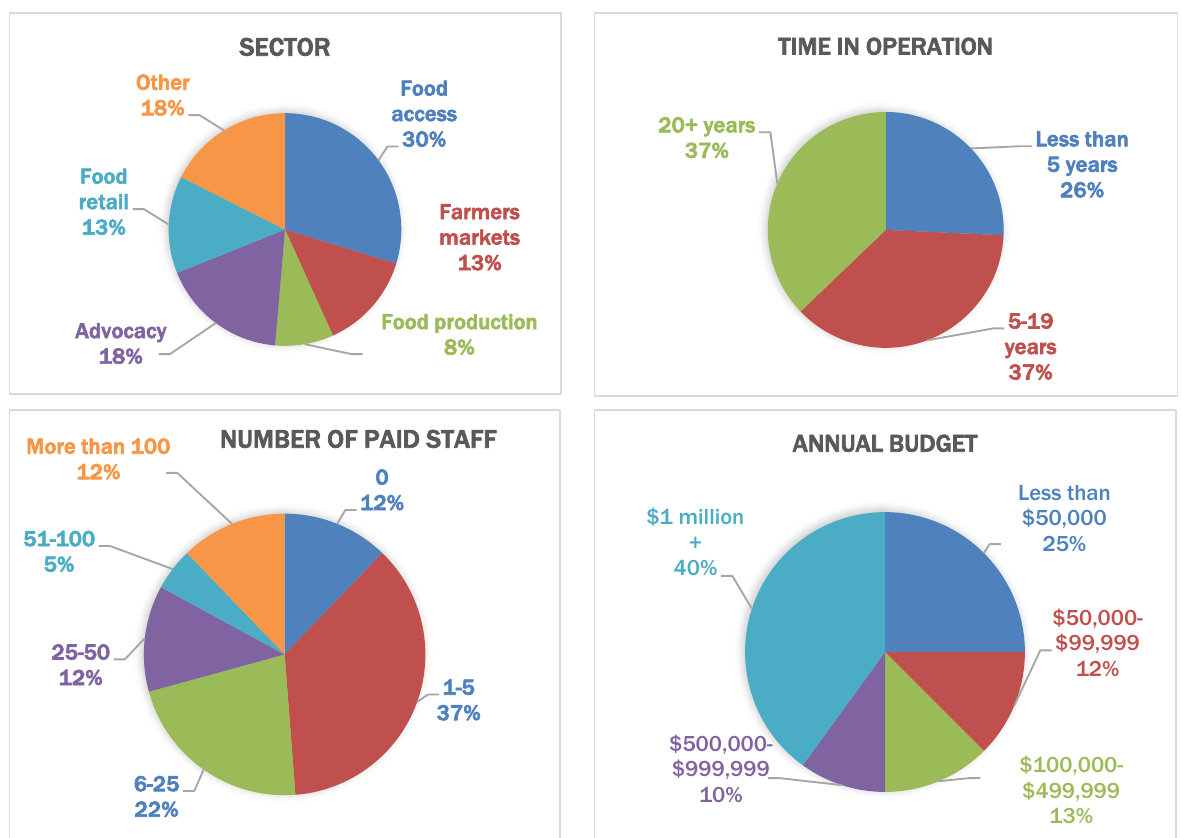
Figure 1. Survey Respondent